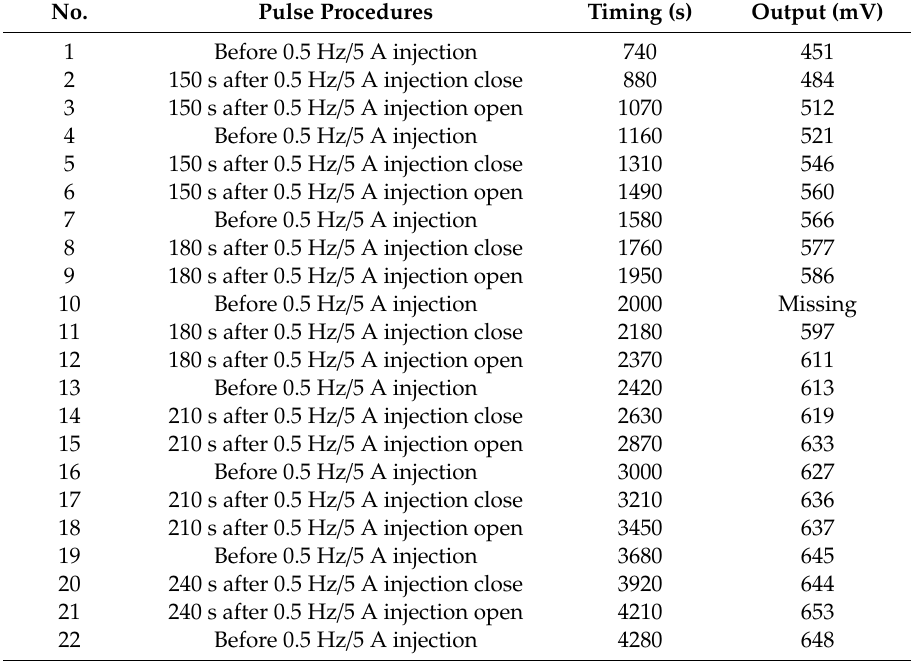
Table 1. Measurement timings and